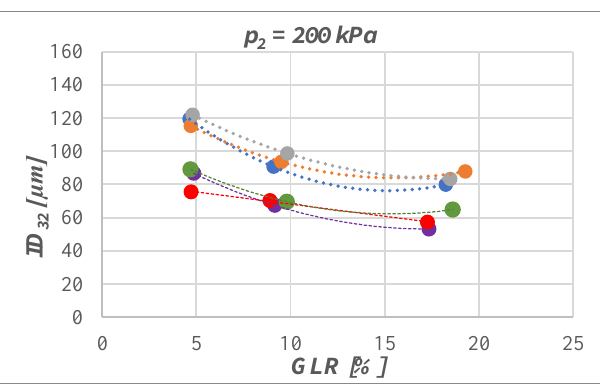
Fig. 8. The influence of GLR on ID 32 for p 2 = 200 kPa .